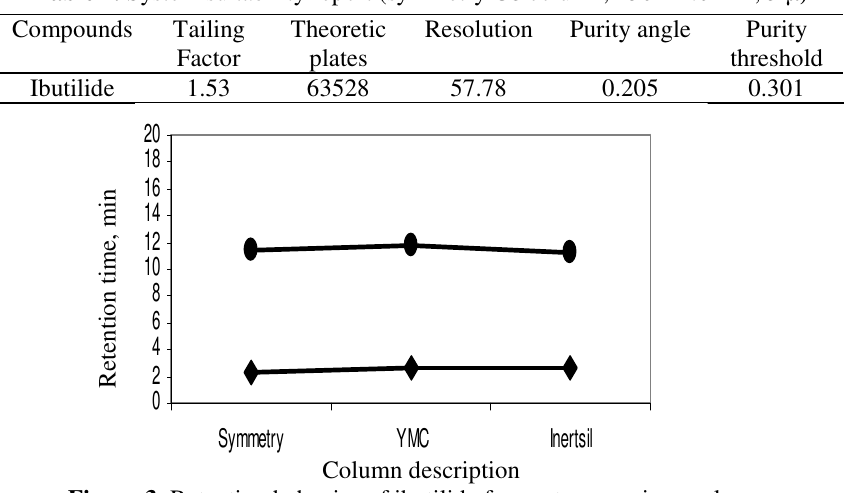
Figure 2. Typical chromatogram. Table 1. System suitability report (symmetry C8 column, 250 x 4.6 mm, 5 µ)